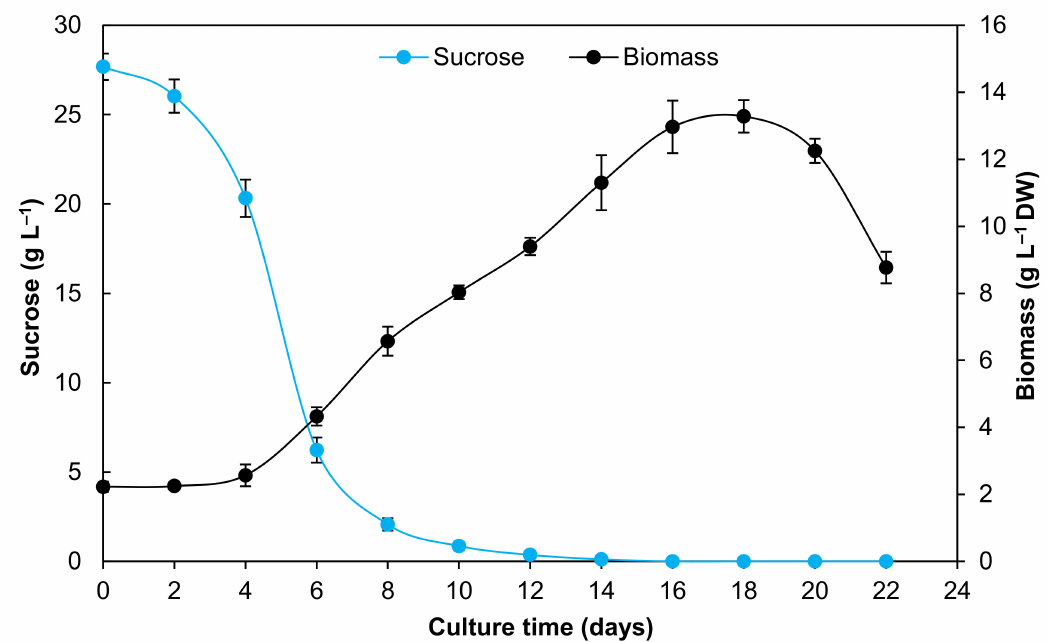
Figure 2. Growth kinetics and consumption of sucrose of the A. pichinchensis cell suspension culture during growth for 22 days in Murashige and Skoog (MS) medium with 1.0-mg L − 1 α -naphthaleneacetic acid (NAA) and 0.1-mg L − 1 6-furfurylaminopurine